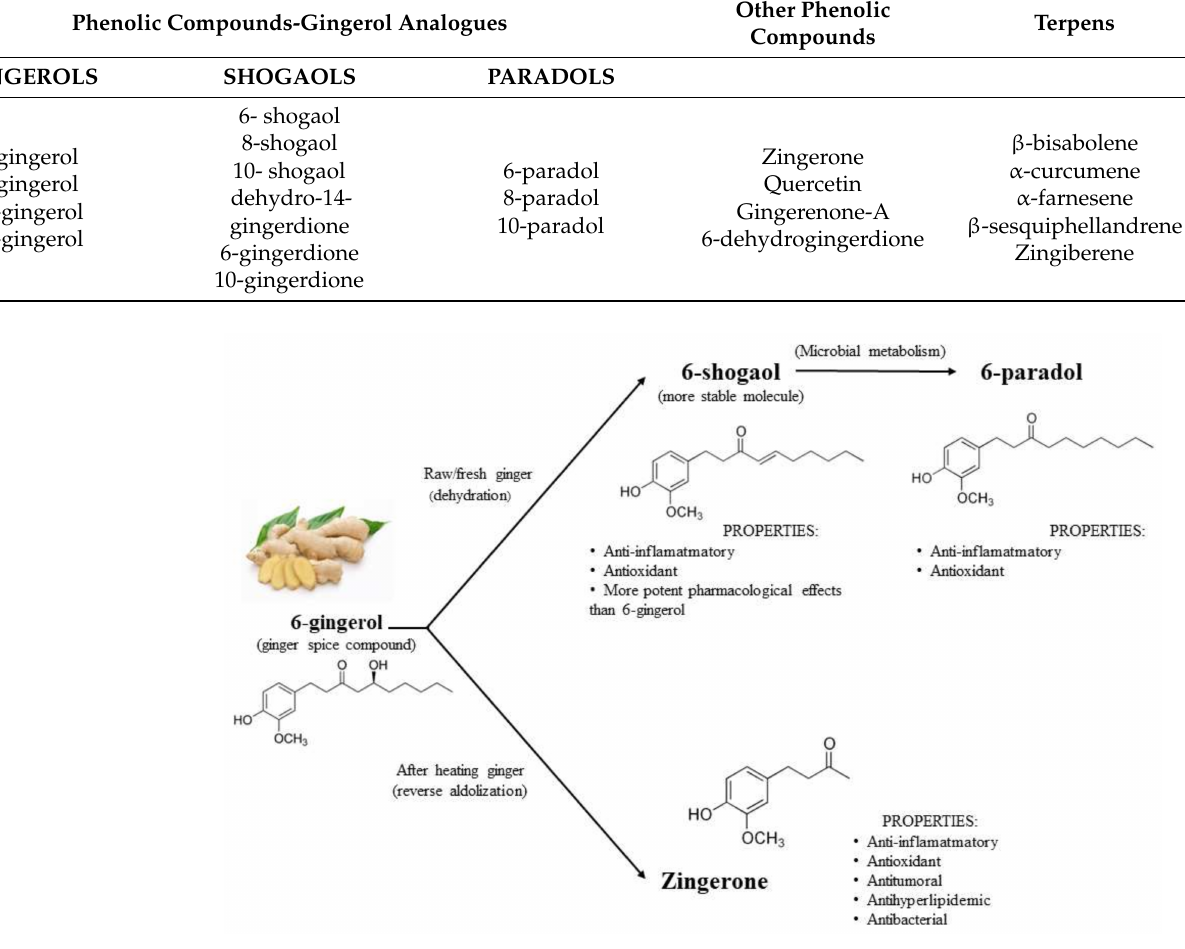
Figure 2. Properties and structure of the 4 main compound of ginger. Adapted of